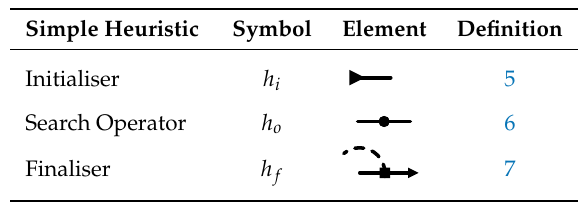
Table 1. Elements based on signal-flow diagrams for representing simple